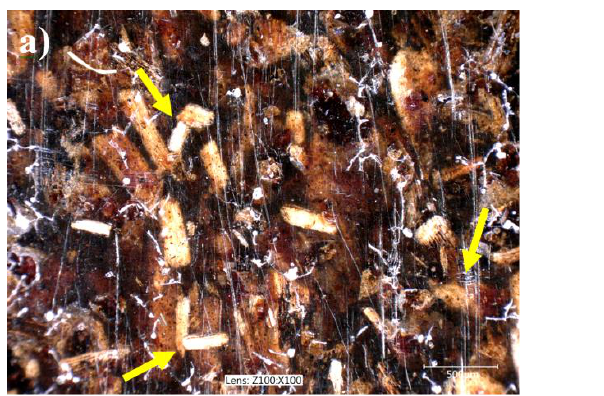
Figure 2. Estimated moduli as a function of observed moduli representing the goodness-of-fit for the Lewis–Nielsen model. Symbols: (  ) PP; (  ) LDPE; (  ) HDPE; (  ) PS; (  ) PETG; (  ) PLA; empty symbols: SP20; full symbols: SPF.